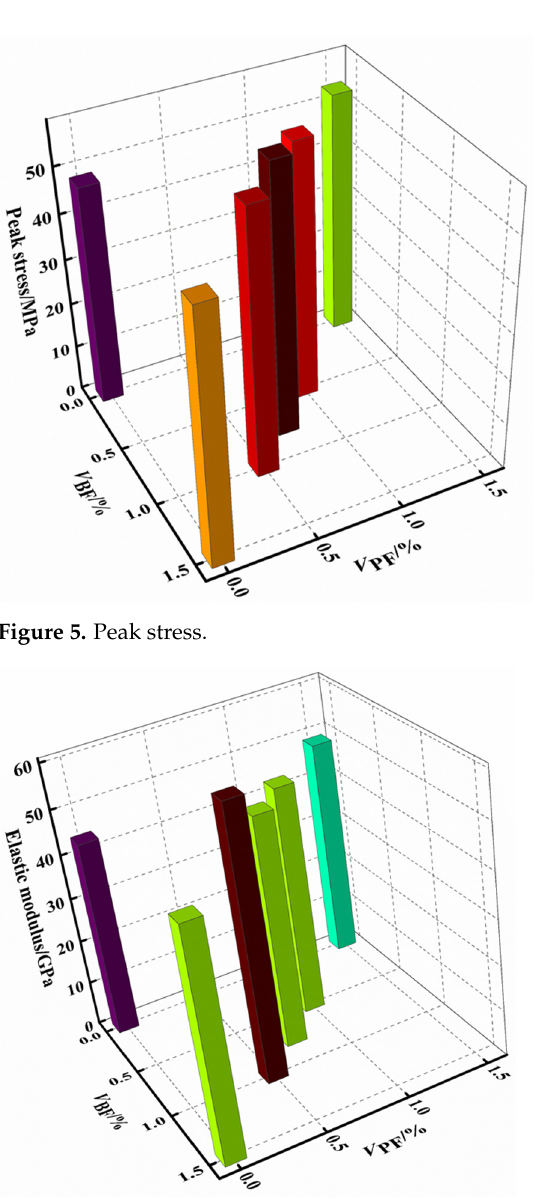
Figure 6. Elastic